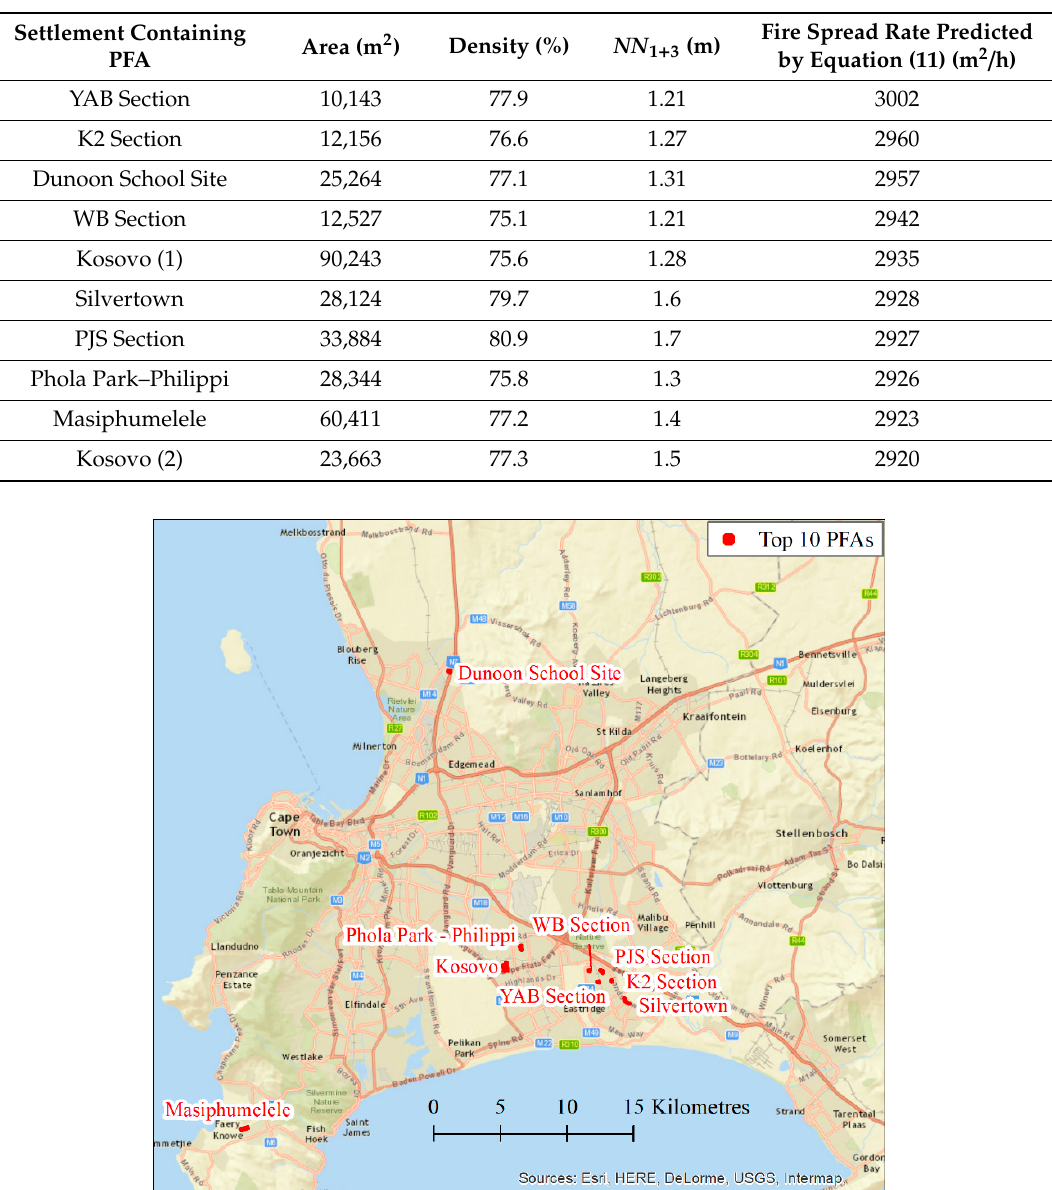
Table 3. PFAs with the highest fire spread rates of the 127 PFAs studied in Cape Town, with their corresponding spatial metrics.